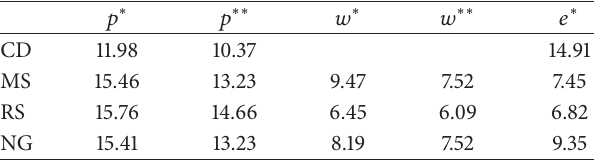
Table 2: Optimal retail prices, wholesale prices, and efforts.